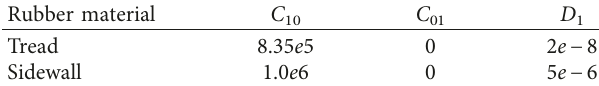
Table 1: Neo-Hookean model parameters of the rubber material. Rubber material